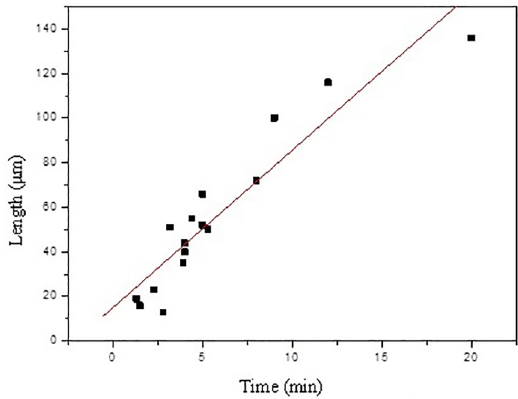
Figure 6. Total length of the filaments as a function of the total retraction time for 20 GUVs of DLPC under external electric field of 10 V/mm, 20 Hz.